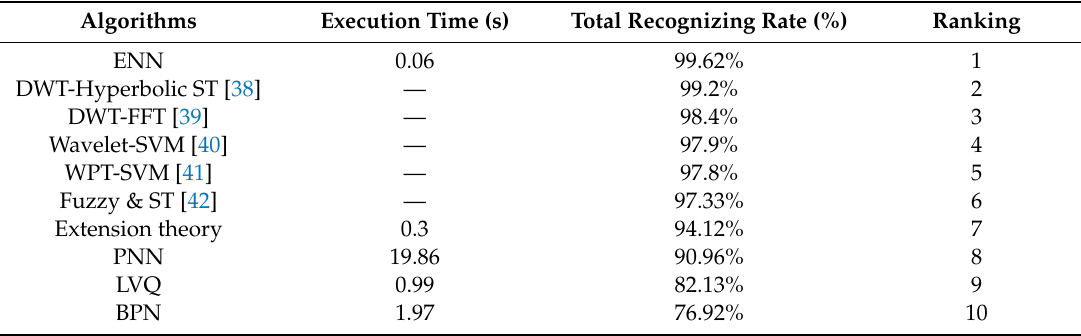
Table 2. Recognition results of ENN and other